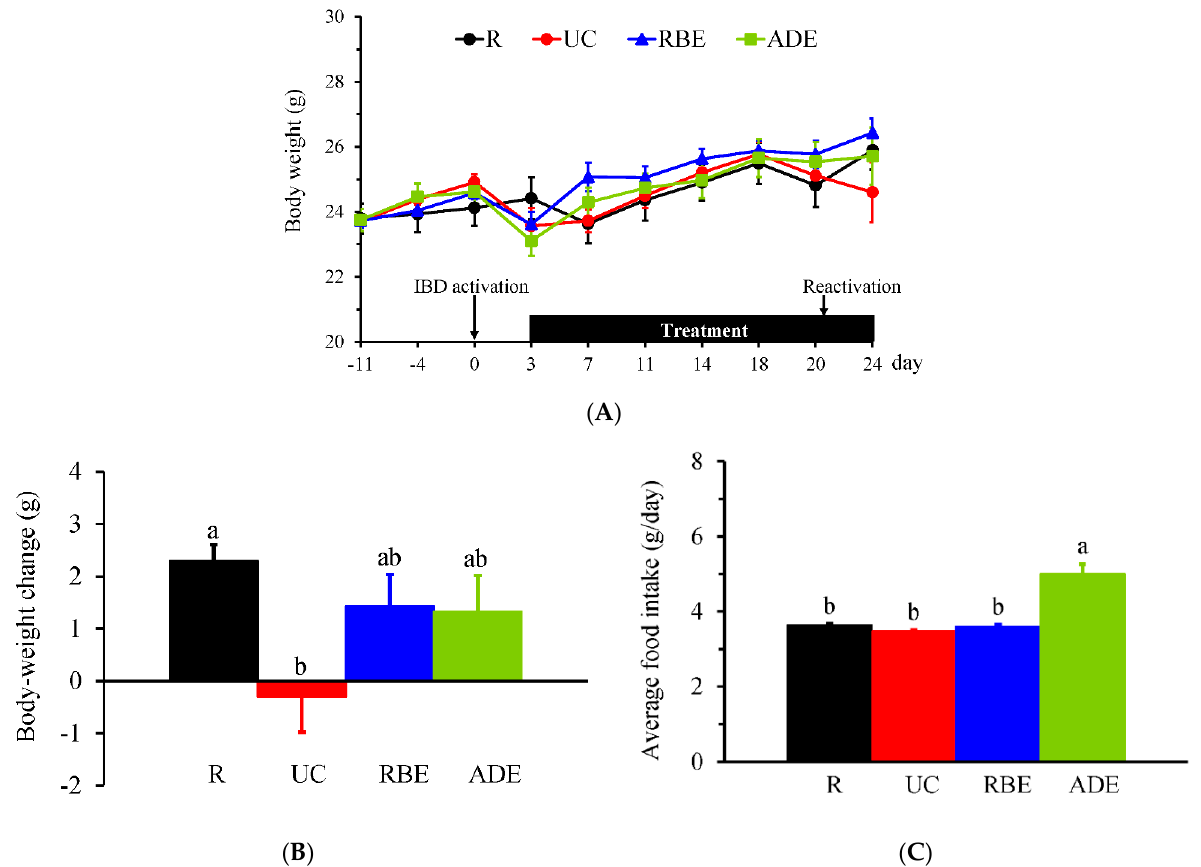
Figure 1. Body weight and food intake of control mice (R group) fed AIN-93M diet and UC mice fed either the AIN-93M diet (UC group) or the AIN-93M diet supplemented with alcohol extract of rice bran (RBE group) or whole-grain adlay seeds (ADE group). ( A ) Body weight before and on the day of UC induction (day 0) until the end of the experiment (day 24). ( B ) Body-weight change and ( C ) average daily food intake from day 0 to day 24. Values are mean ± SEM, n = 10 − 11 per group. Different superscript letters indicate significant differences (one-way ANOVA and Duncan’s multiple range test, p <